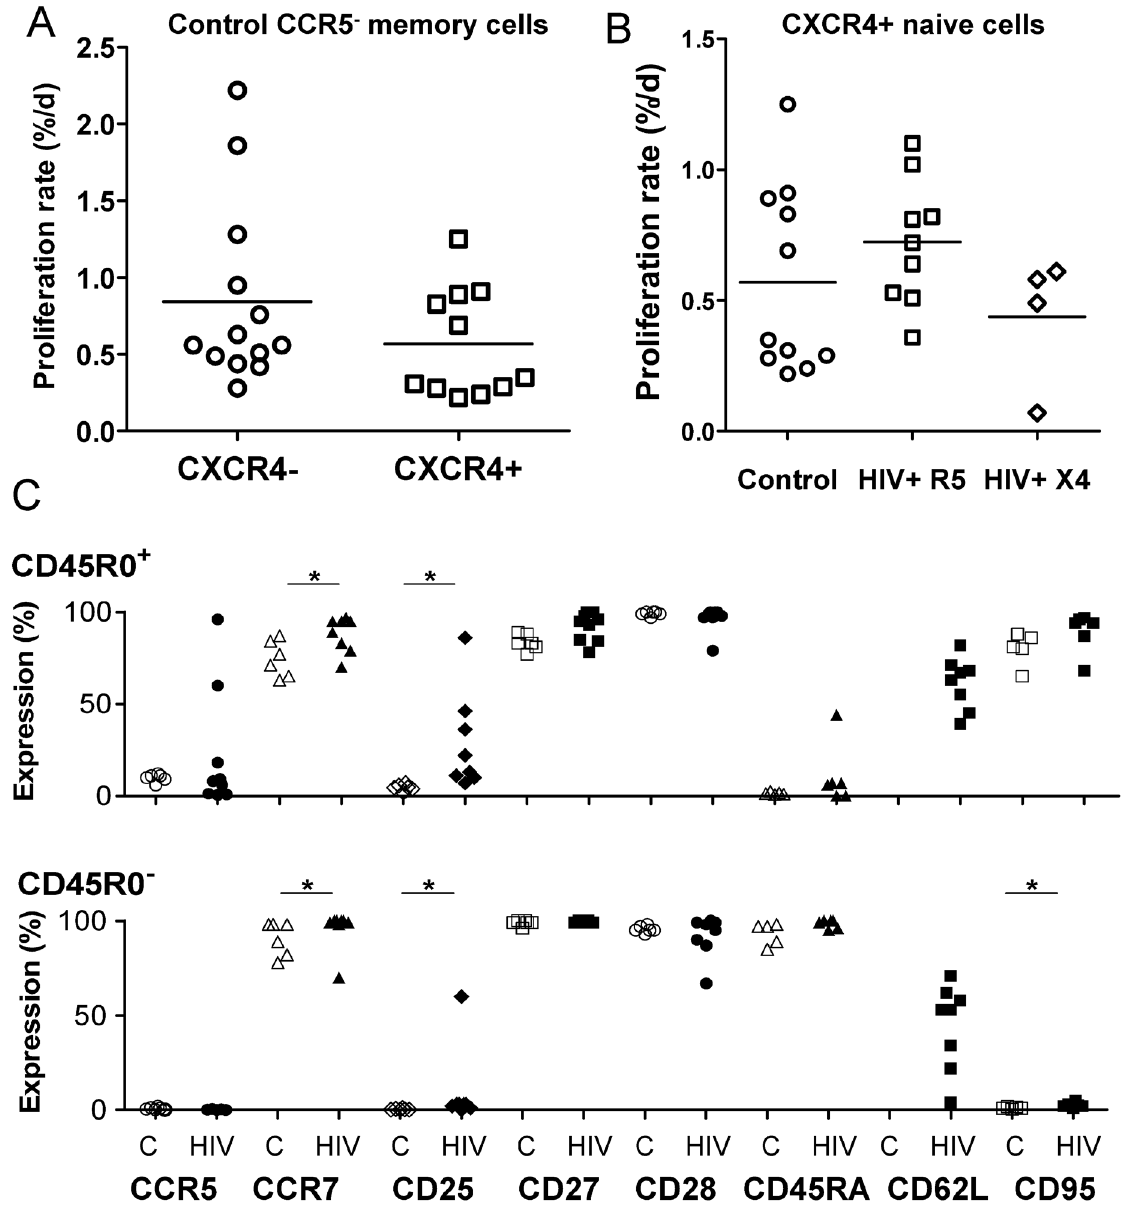
Figure 4. CXCR4 expression and turnover in CCR5 2 memory (CD45R0 + ) T-cells, CXCR4 + naı¨ve (CD45R0 2 ) T-cells and phenotypic correlates. (A) Proliferation rates in CXCR4 2 (circles) and CXCR4 + (squares) CCR5 2 CD45R0 + T cells in healthy controls; horizontal bars represent means, P=NS by t-test. (B) Modeled proliferation rates in CXCR4 + naive (CD45R0 2 ) CD4 + T cells from control subjects (circles), HIV-infected subjects with an R5-tropic virus (squares), and HIV-infected subjects with an X4-tropic virus (diamonds); horizontal bars represent means, P=NS by t-test. (C) Phenotype of CXCR4 + cells according to CD45 expression, either CD45R0 + (upper panel) or CD45R0 2 (lower panel). Values are shown from healthy control subjects (C, open symbols) and HIV + subjects (H, closed symbols); * indicates significant difference between control and HIV data (P , 0.05 by Mann Whitney test). CD62L data was not available for control subjects.